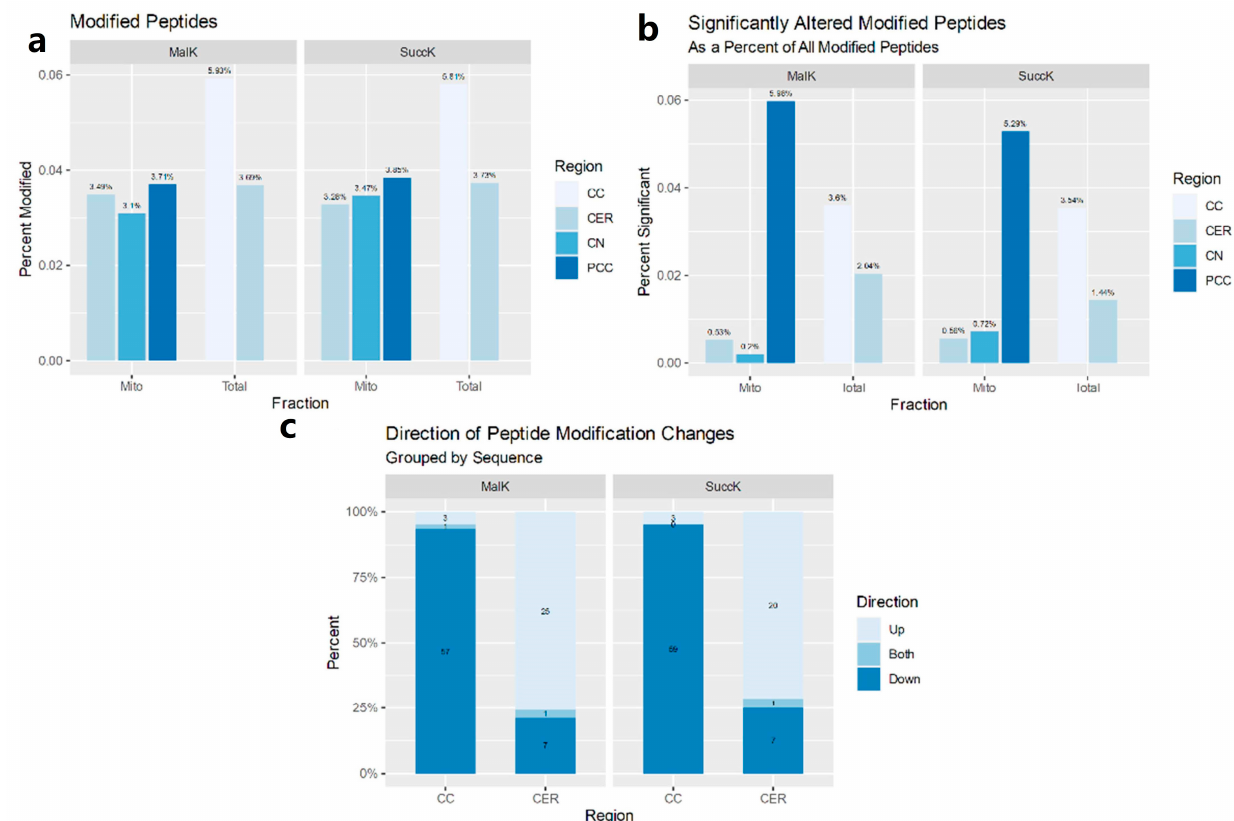
Figure 1. Data involving the relative frequency of the quantified and modified peptides in the posterior cingulate cortex (PCC), corpus callosum (CC), and cerebellum (CER) for succinylation and malonylation: ( a ) The percentage of identified peptides that were modified in mitochondrion- enriched fractions, left, and those that were dysregulated (ANOVA ≤ 0.05), right; ( b ) the percentage of modifications that were increased or decreased (ANOVA ≤ 0.05) in the total cell lysates of the corpus callosum and cerebellum—accession numbers that had different sites found with increased and decreased levels of a modified peptide were labeled as Both; ( c ) the total numbers of succinylation and malonylation sites in the full cell lysates of the corpus callosum and cerebellum, also indicating the percent of these sites that differed in SCZ (ANOVA ≤ 0.05). Posterior cingulate